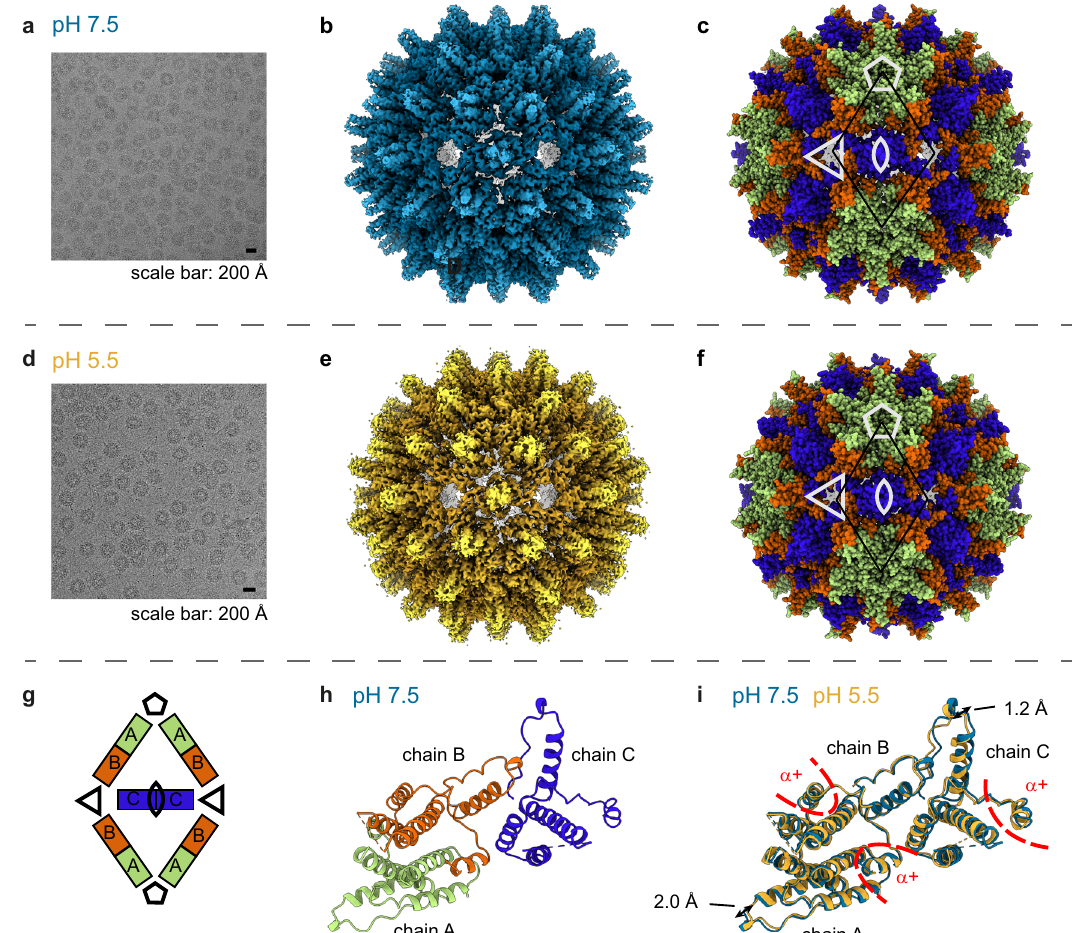
Fig. 2 |ACNDVCp atpH 7.5andpH5.5havethesameprotein fold. a , d Cryo-EM micrograph of ACNDV capsids at pH 7.5 and pH 5.5 showing icosahedral T =3 parti- cles. b , e Cryo-EM density maps of the ACNDV capsid at pH 7.5, (resolution of 3.7Å) plottedatacontourlevelof4 σ andoftheACNDVcapsidatpH5.5(resolutionof3.9Å plotted at a contour level of 3 σ . c , f Whole capsid structures where chain A of the asymmetric unit is colored in green, chain B in orange and chain C in blue. The white shapes indicate the symmetry axes in the T =3 particle. Chains within the black